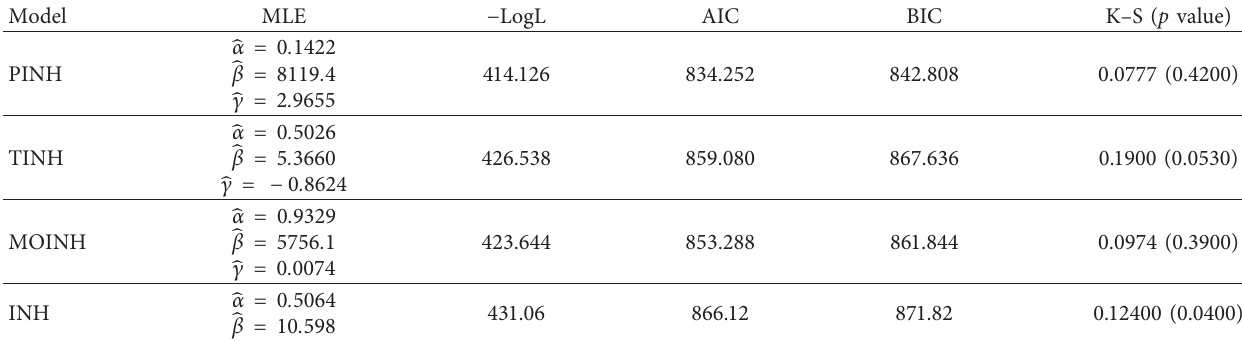
Table 5: ML estimates and goodness-of-fit measures for the first data